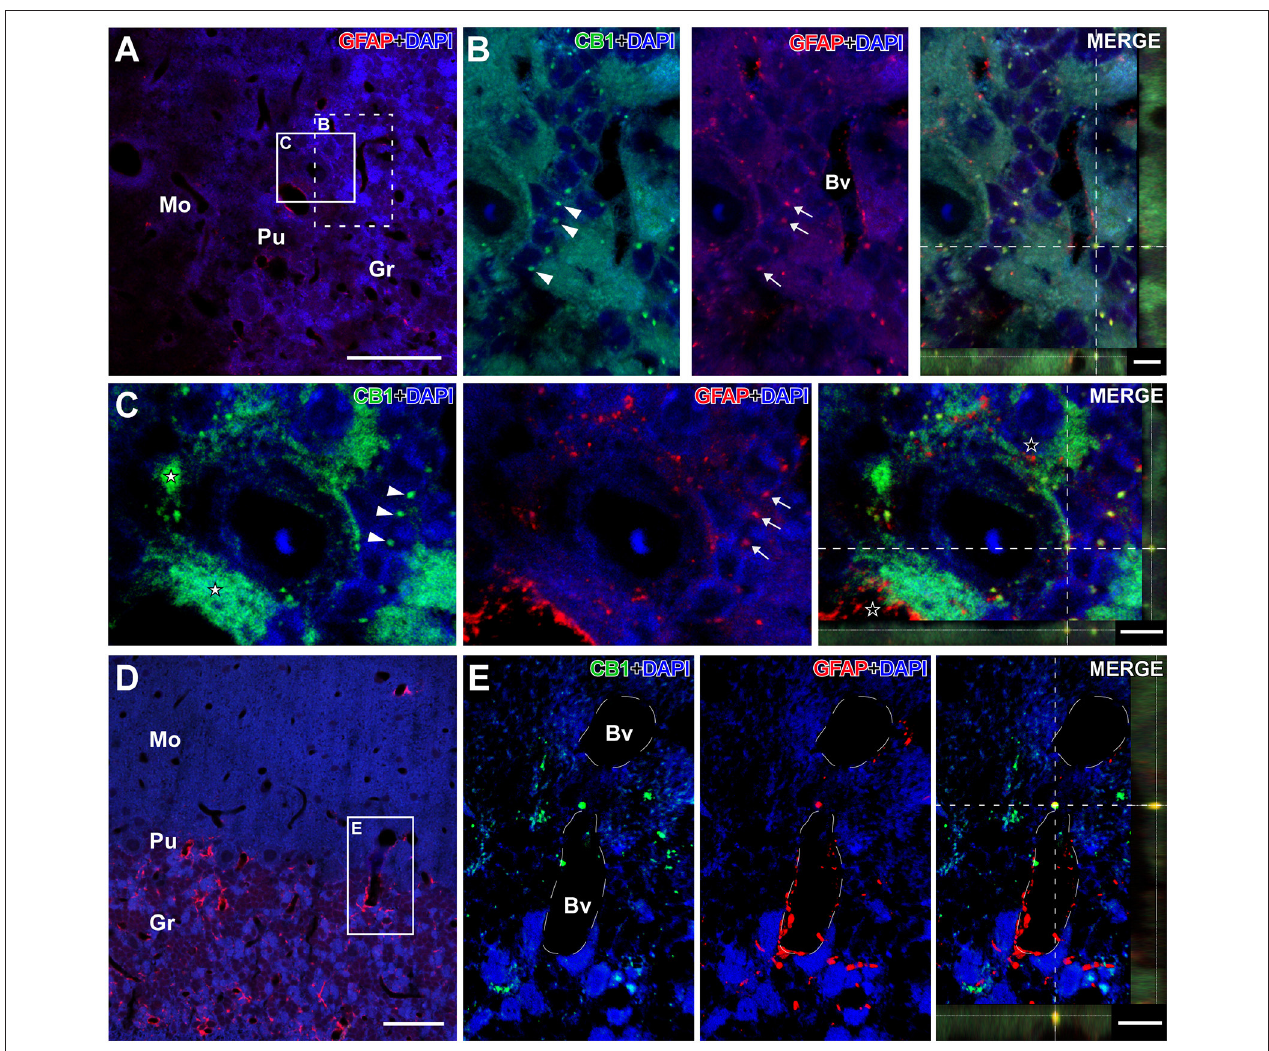
FIGURE 5 | Details of CB1- and GFAP-immunolabeling in the cerebellum of the GASH/Sal. Details of CB1- and GFAP-immunolabeling in the cerebellum of the GASH/Sal (depicted in green and red, respectively). (A) Low magnification confocal microscopy image of a 6- µ m coronal section shows immunolabeling for GFAP-immunolabeling (in red) in the cerebellum of a control hamster. (B) High magnification photomicrographs corresponding to the dashed square in (A) shows details of CB1-immunolabeled puncta (arrowheads) as well as GFAP-immunolabeled glial fibers (arrows) distributed around cerebellar granule cells. (C) High magnification confocal microscopy images corresponding to the white square in (A) shows large putative axonal puncta immunolabeled for CB1 (white stars) nearby a Purkinje cell and small CB1-immunolabeling punctate (arrowheads) in close apposition to granular cells. Note that GFAP-immunolabeled glial fibers distributed around cerebellar granule cells (arrows) as well as in the vicinity of CB1-immunolabeled terminals (black stars in the merge panel). The maximum projection of confocal images corresponding to the panels in (C) was displayed in the 3D video of Supplementary Material 4 . (D) Low magnification confocal microscopy image show GFAP-immunolabeling (in red) associated with blood vessels in the cerebellum. (E) High magnification photomicrograph corresponding to the square in D shows details of CB1- and GFAP-immunolabeling in the vicinity of a blood vessel. Colocalization of CB1 with GFAP can be observed in the orthogonal view of the merged confocal images. DAPI (in blue) was used for nuclear staining to show cell position. Scale bars = 50 µ m in (A,D) ; 5 µ m for all panels in (B,C) ; 10 µ m for all panels in (E) . Bv, Lumen of blood vessel; Gr, Cerebellar granular layer; Mo, Cerebellar molecular layer; Pu, Purkinje cell